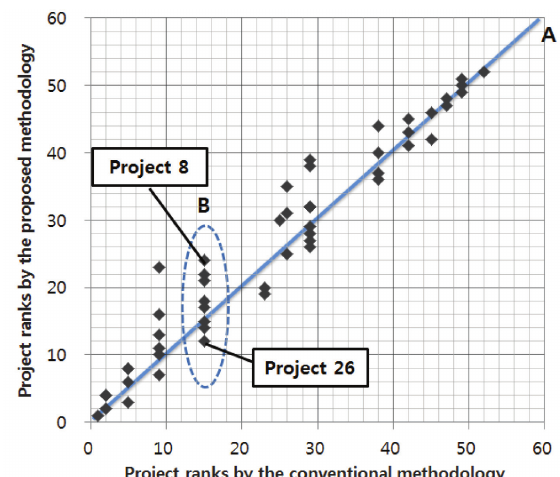
Fig. 5. Comparison of project ranks by the conventional methodology and project ranks by the proposed